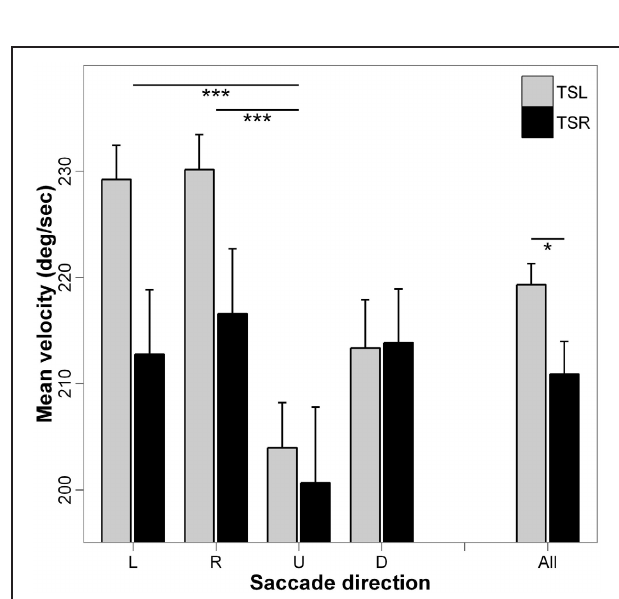
FIGURE 5 | Mean values of mean velocity for each saccade direction (L, leftward; R, rightward; U, upward; D, downward) and tinnitus side (TSL, tinnitus side left; TSR, tinnitus side right). Error bars represent the standard error. The symbol * indicates a statistically significant effect ( ∗ p < 0 . 05; ∗∗ p < 0 . 01; ∗∗∗ p < 0 . 001).